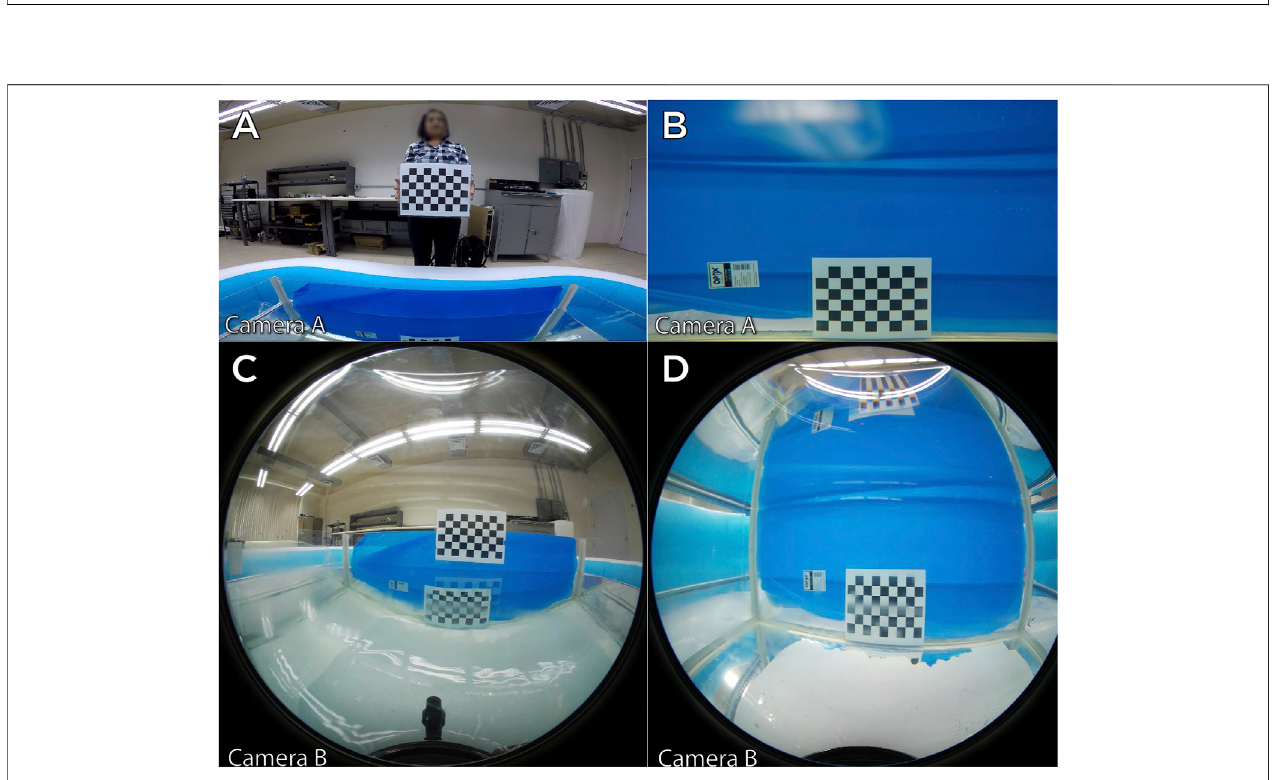
FIGURE 9 | Comparison of two wide angle and fi sheye cameras in different propagation medium. (A) : wide angle camera on air. (B) : wide angle underwater. (C) : fi sheye camera on air. (D) : fi sheye camera underwater.